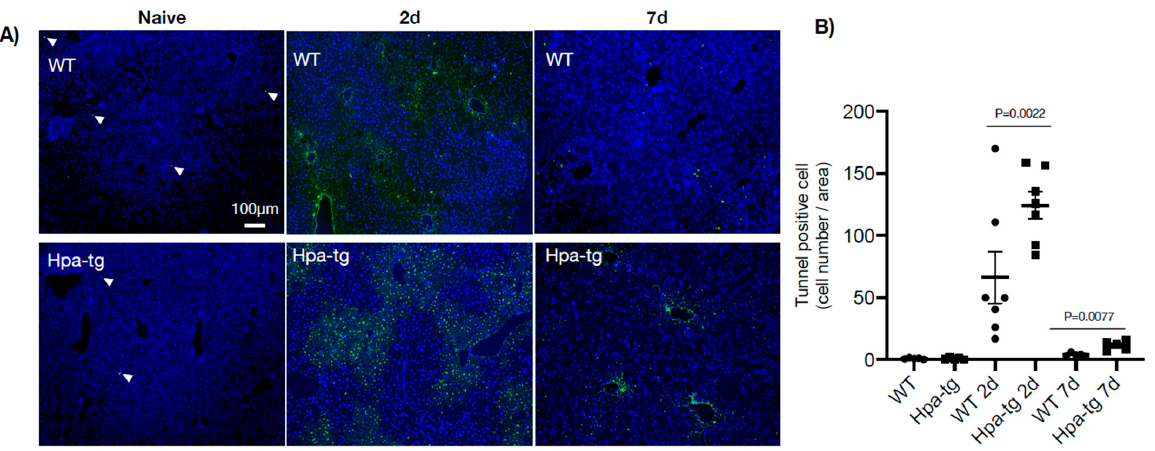
Figure 3. Cell apoptosis in livers from naïve and CCL4-treated mice. ( A ) Tissue sections derived from naïve and CCL4-treated WT and Hpa-tg livers were subjected to TUNEL staining. Representative images were counted for positively stained apoptotic cells ( × 10 magnification). Arrowheads: indicate trace TUNEL-positive cells in the naïve mice, set arbitrarily to a value of 1. ( B ) Average numbers of TUNEL-positive cells/microscopic field. WT and Hpa-tg represent naïve mice. The values are averages of more than 10 counted fields/mouse. ( n =